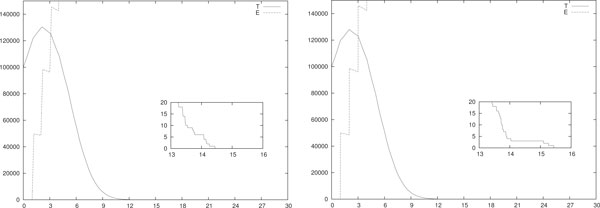
Single run, daily ACI mono-therapy. Single-run of piece-wise constant (left) and impulsive (right) daily ACI. In (left) A = 0.2 and bi = 5 · 104/(V A) for i = 1, . . . , 30. In (right) wi = 5 · 104 for i = 1, . . . , 30. In both cases T(0) = 105 and E(0) = I(0) = 0. All the other parameters are as in Table 3.